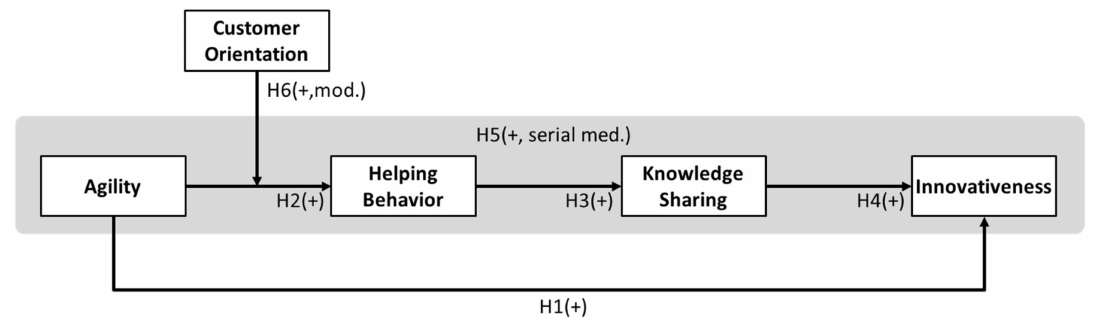
Figure 2. The working mechanism research model of the Agile approach.